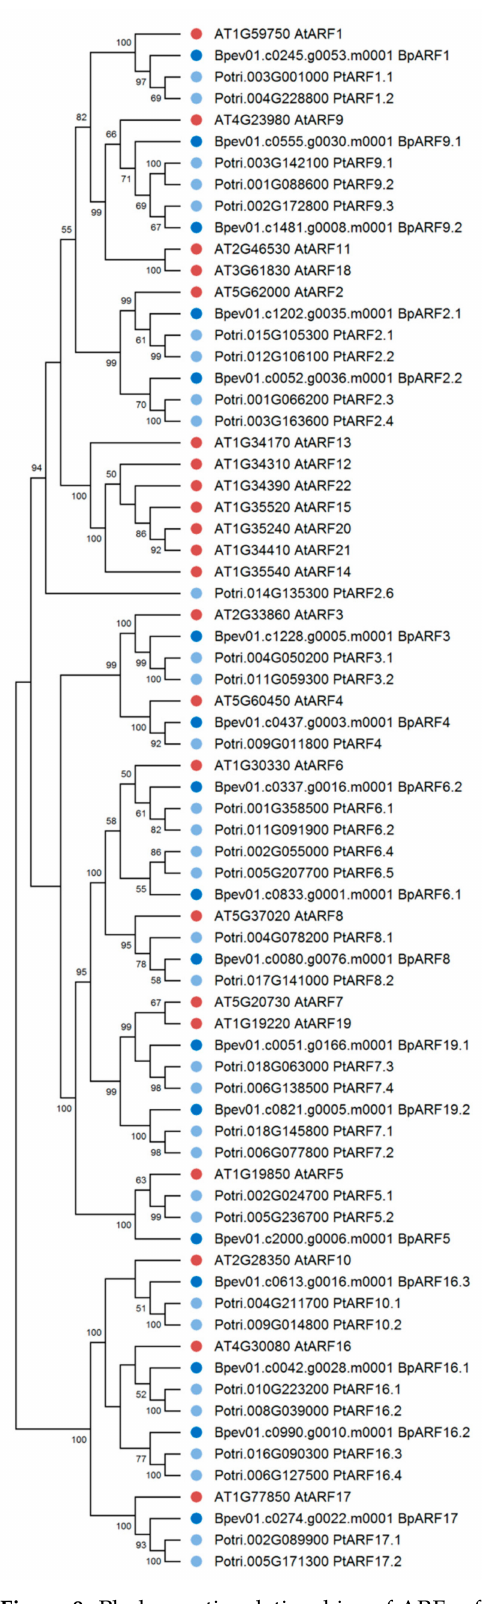
Figure 9. Phylogenetic relationships of ARFs of B. pendula (dark blue dots), A. thaliana (red dots), and P. trichocarpa (blue dots). Bootstrap values (1000 replicates) are shown next to the branches, and only those values greater than 50 are displayed. The access codes of the A. thaliana and P. trichocarpa proteins in the TAIR and Phytozome databases are indicated next to the corresponding